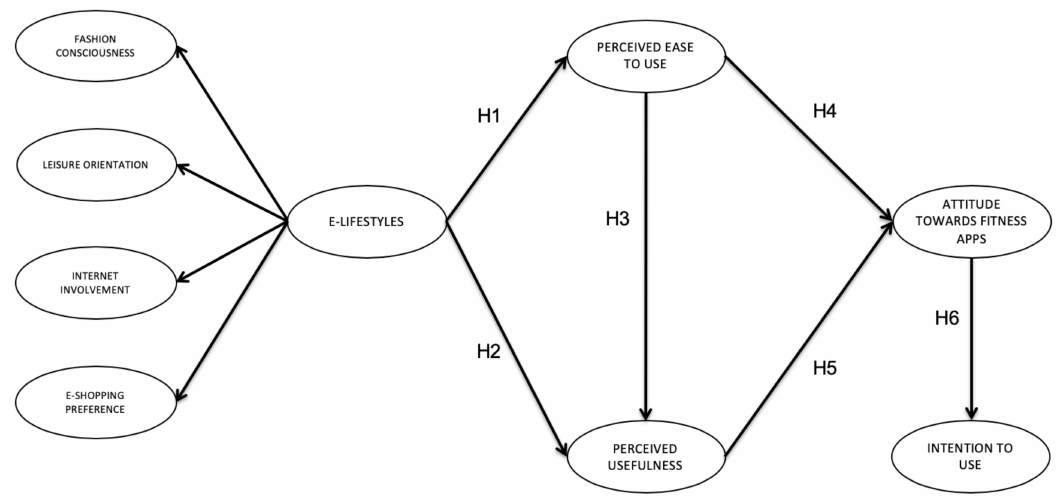
Figure 1. Proposed